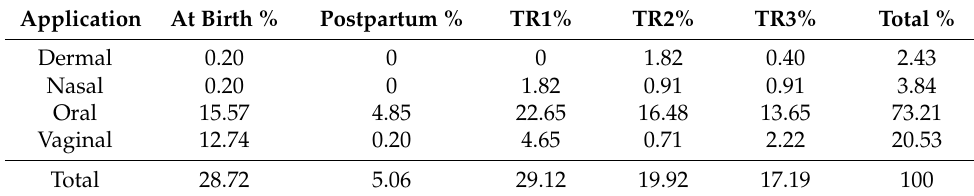
Table 4. Distribution of medicinal plants according to their mode of administration.